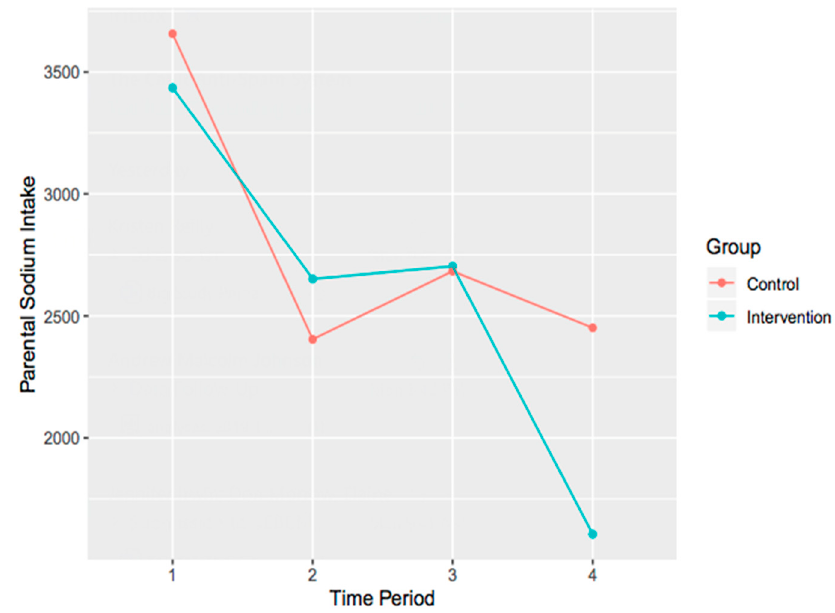
Figure 2. Interaction plot of parental changes in sodium intake over time for both control and intervention groups.